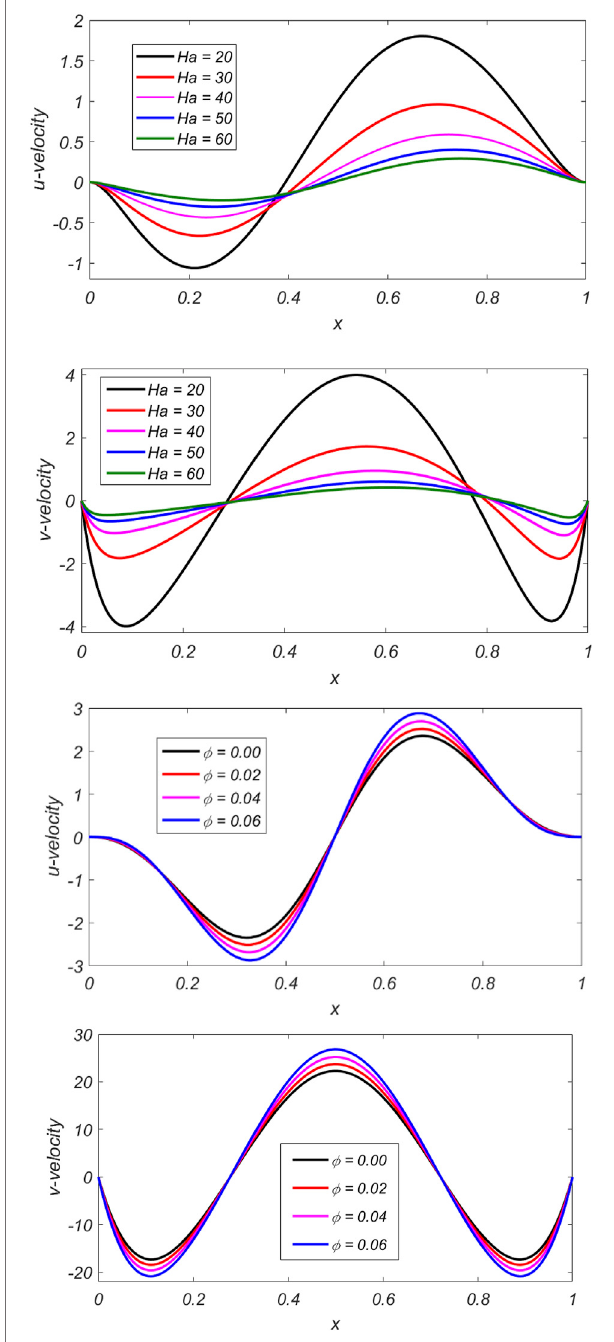
FIGURE 9 | Impacts of velocity components on Hartman number (Ha) and volume fraction. ϕ .